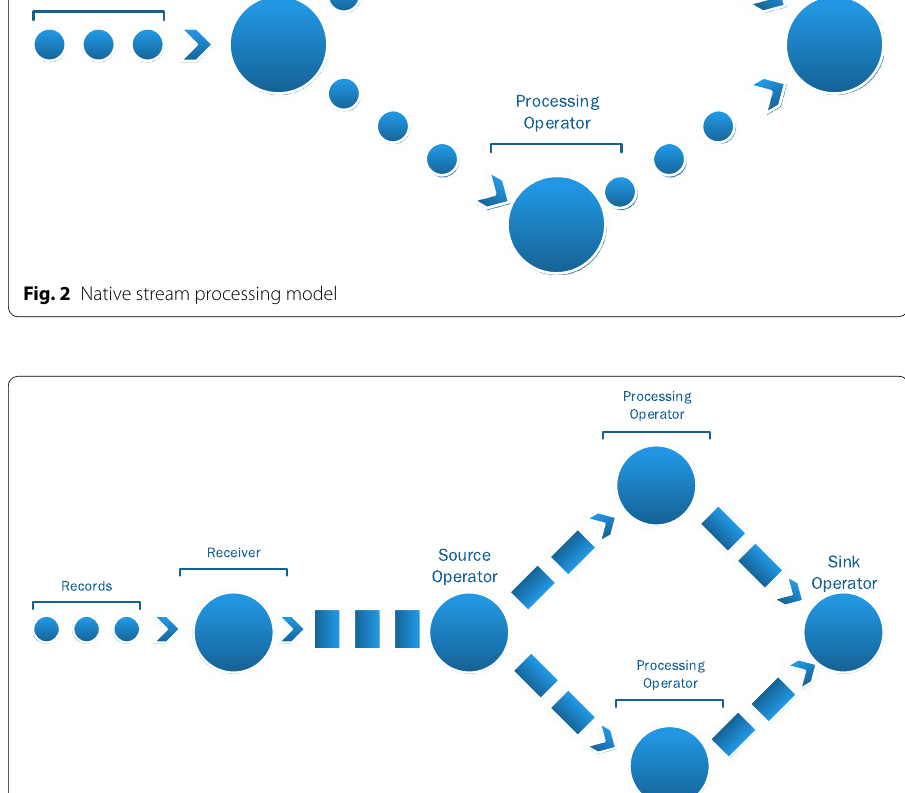
Fig. 3 Micro-batch stream processing